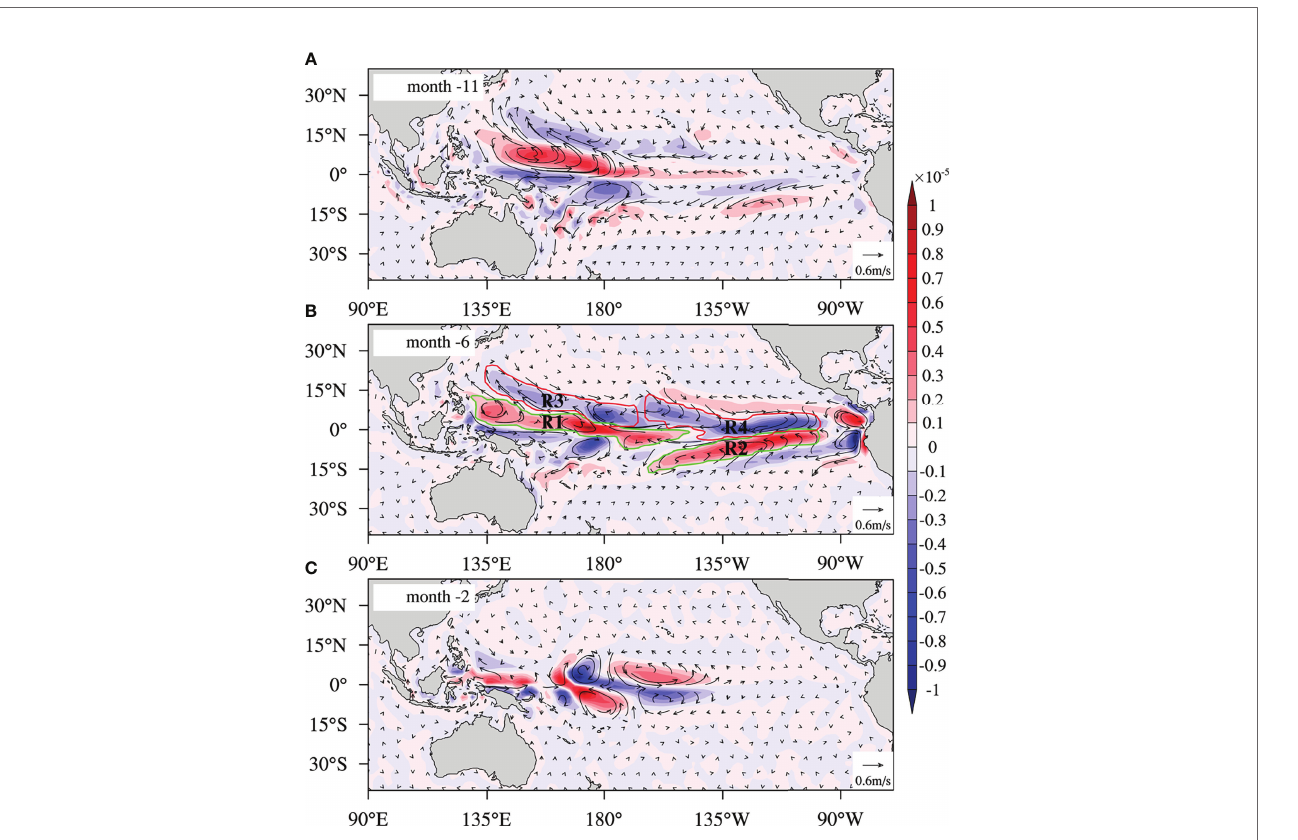
FIGURE 5 | Horizontal distributions of the sensitivity-like wind velocity perturbations (vectors; m s -1 ) and the corresponding wind curl (color shading; s -1 ) at (A) month – 11, (B) month – 6, and (C) month – 2. The outlined regions in (B) indicate the independent perturbations used to investigate the dynamical mechanisms in subsection